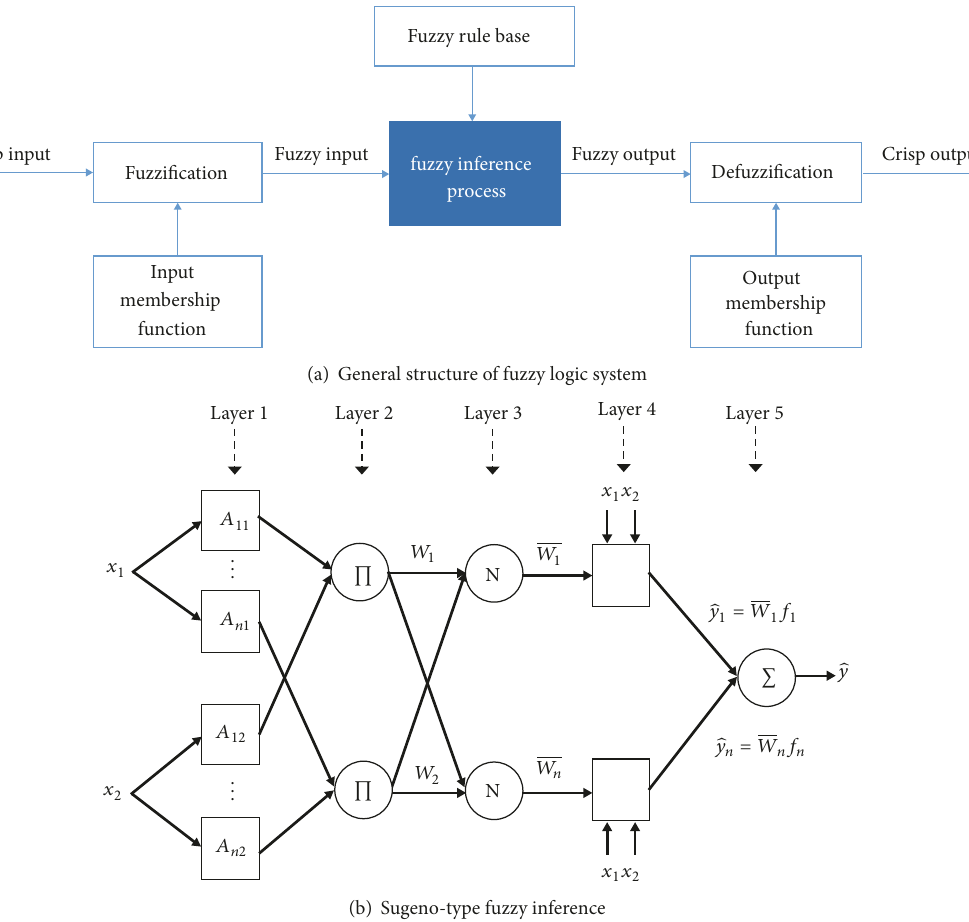
Figure 1: (a) The general structure of a typical fuzzy logic system and (b) Sugeno-type fuzzy inference system [6].